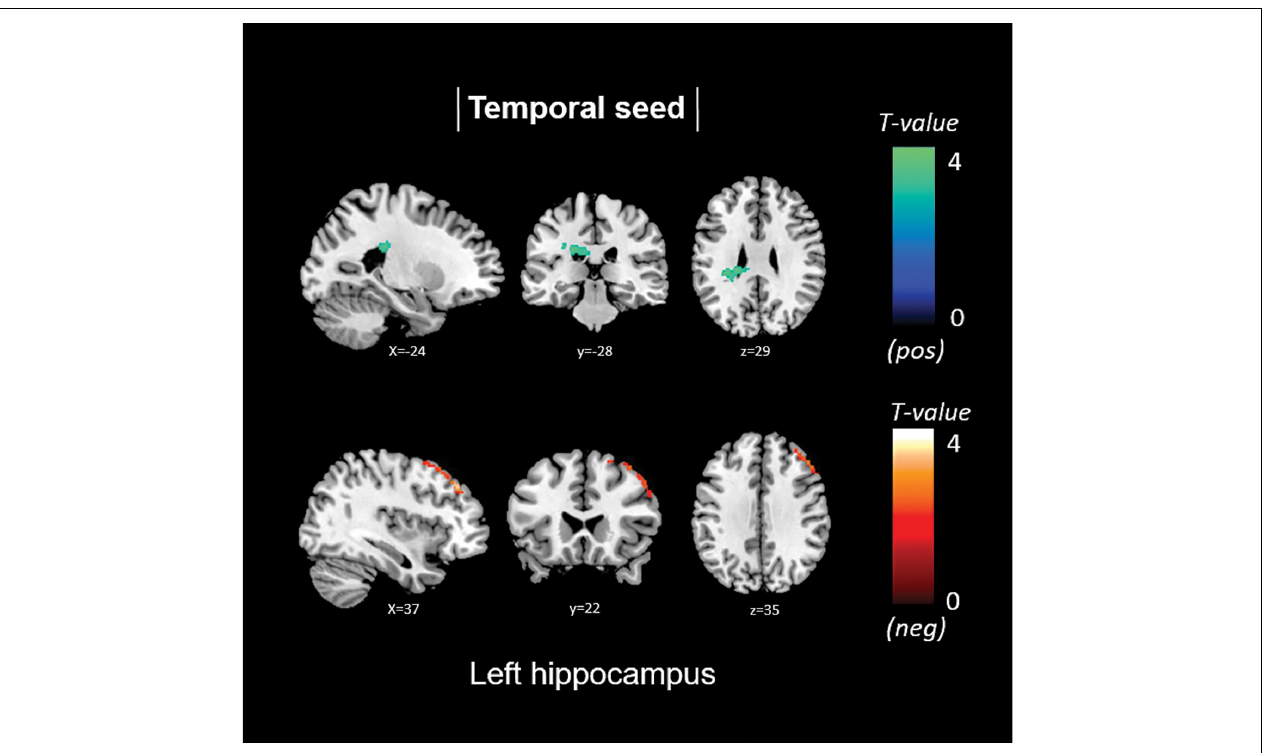
FIGURE 6 | Positive (blue) and negative (red) correlations between brain functional connectivity of selected unilateral seed regions and total anosognosia